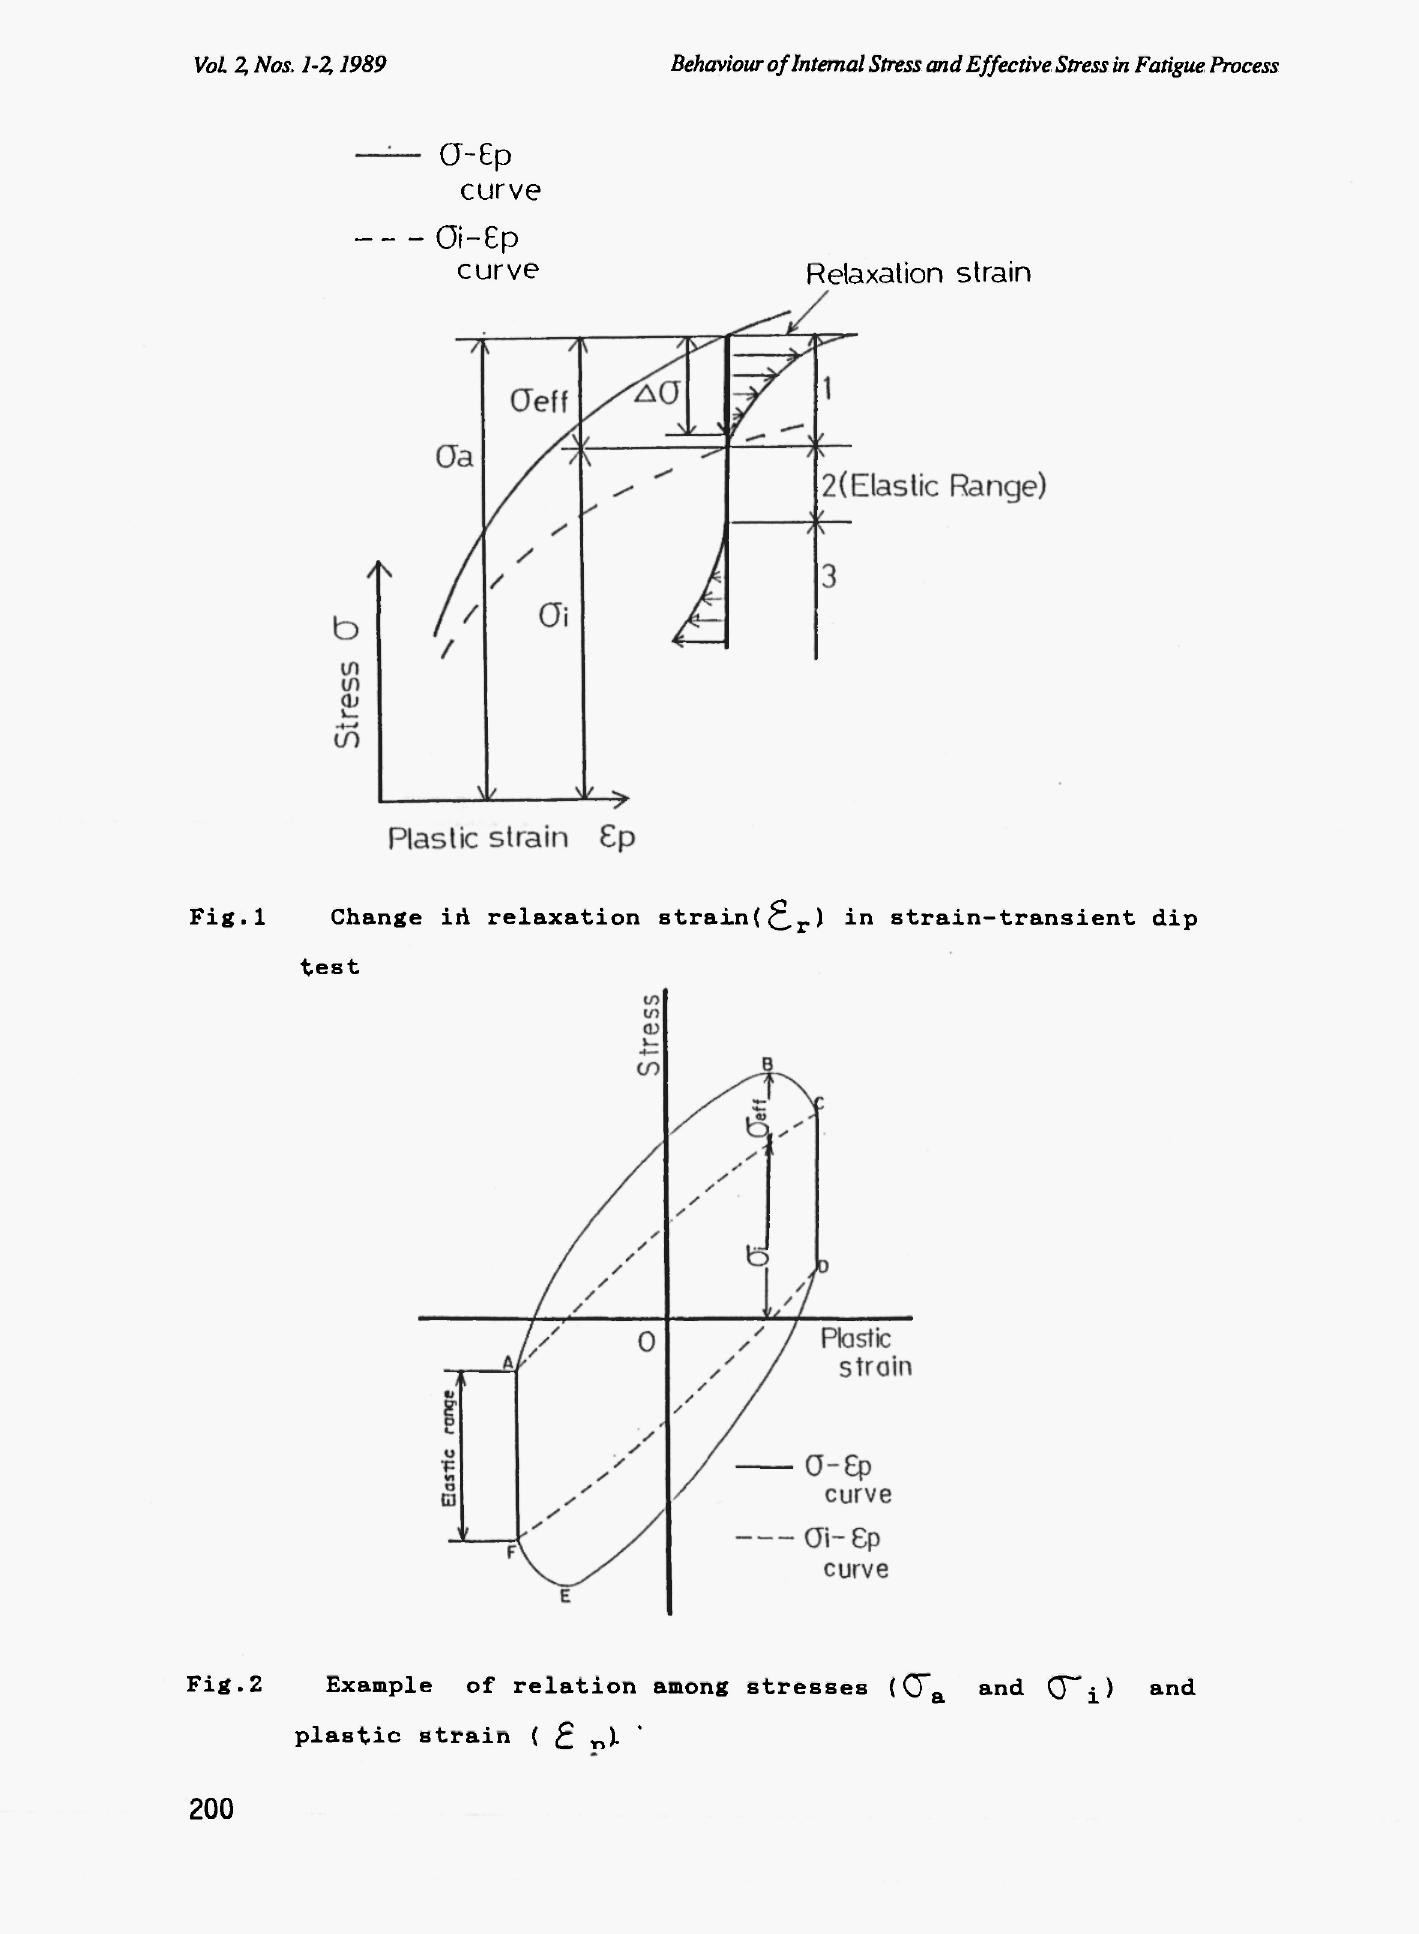
Fig.2 Example of relation among stresses ( 0~ a and (J~^) and plastic strain ( ^ ).